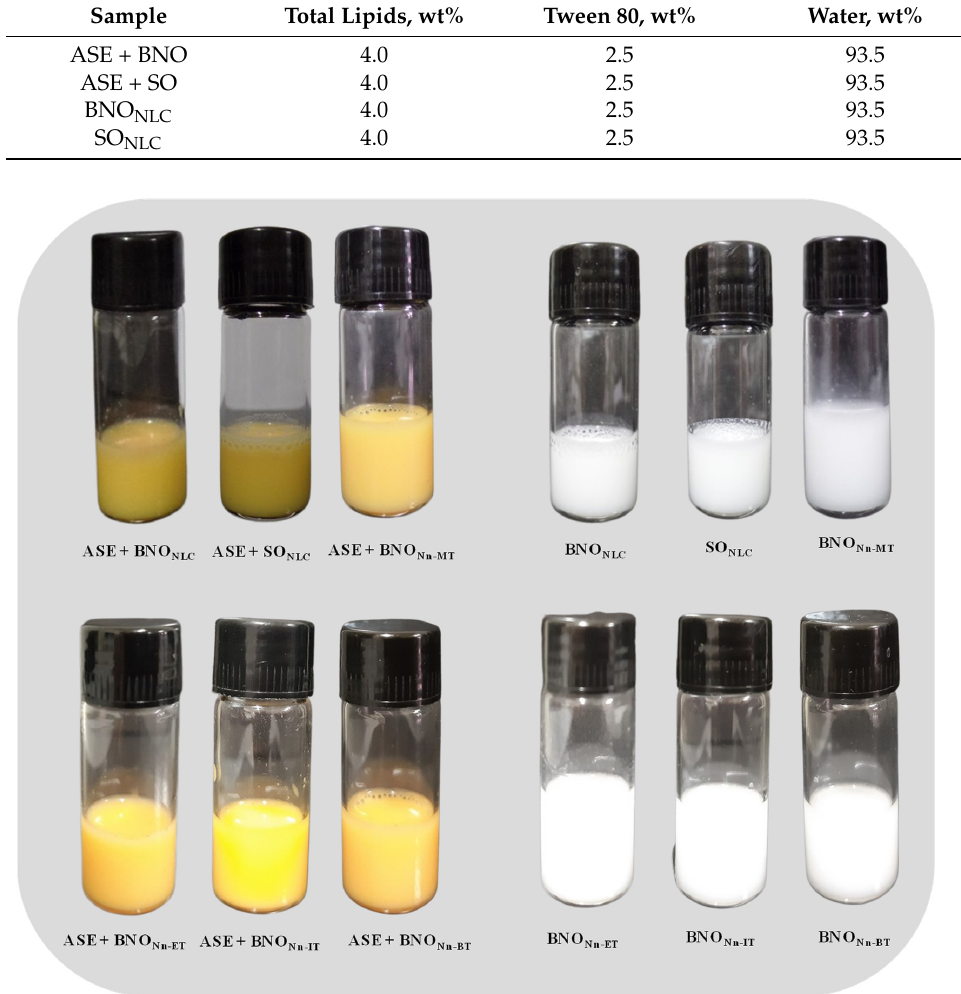
Figure 2. Visual observation of the formulations.